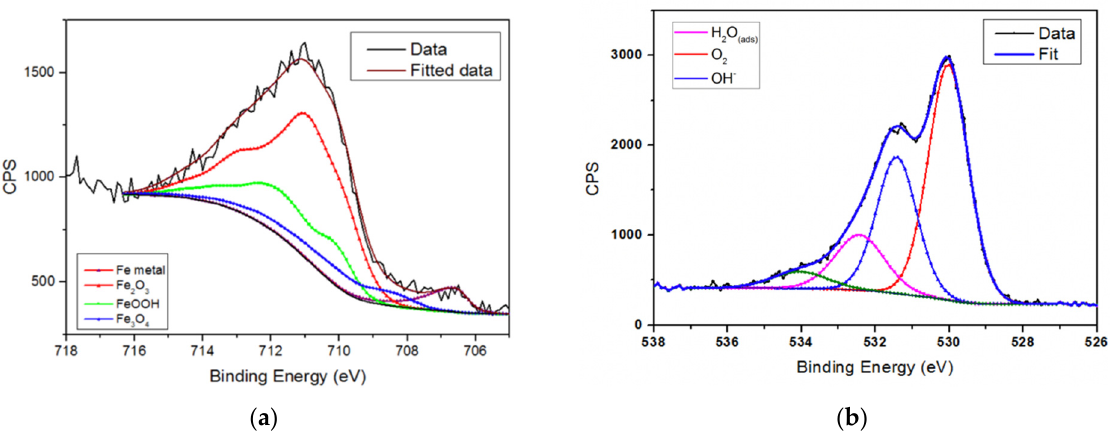
Figure 5. High-resolution XPS ( a ) Fe 2p and ( b ) O 1s spectrum of Sample 4. Passive layer is formed with potentiostatic polarisation for 6 h at 0.4 V (vs. Ag/AgCl) in 0.1 M NaOH solution. Figure 6a,b present the fractions of Fe 3 O 4, γ -Fe 2 O 3 and FeOOH in the passive film for all samples after passivation at 0.2 V and 0.4 V, respectively. First, it is possible to observe